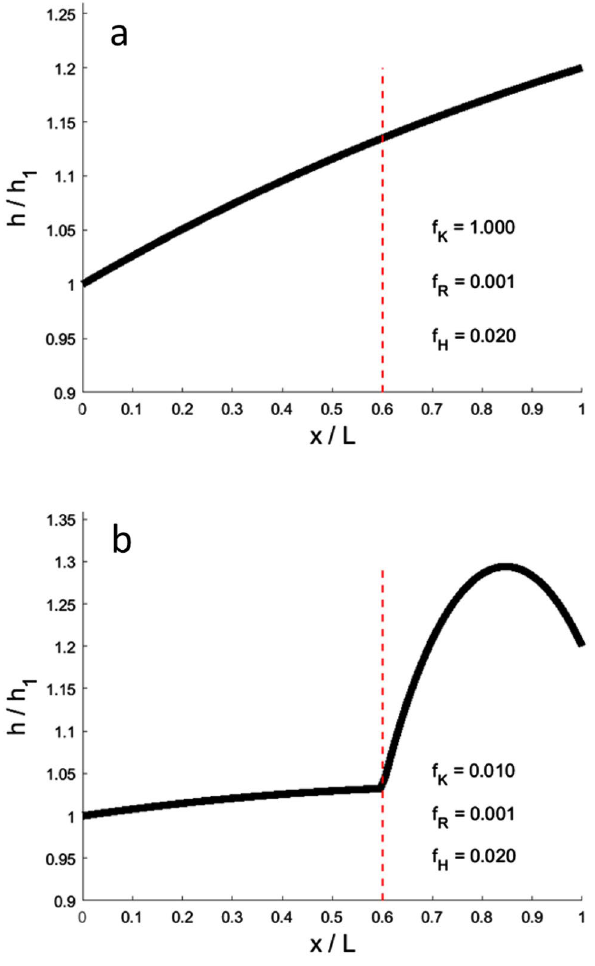
Fig. 2 Water table as a function of position between both rivers for two ratios of hydraulic conductivity, f K = K 2 ∕ K 1 . a Homogeneous and b heterogeneous aquifer. Dashed red line shows position of interface between materials x